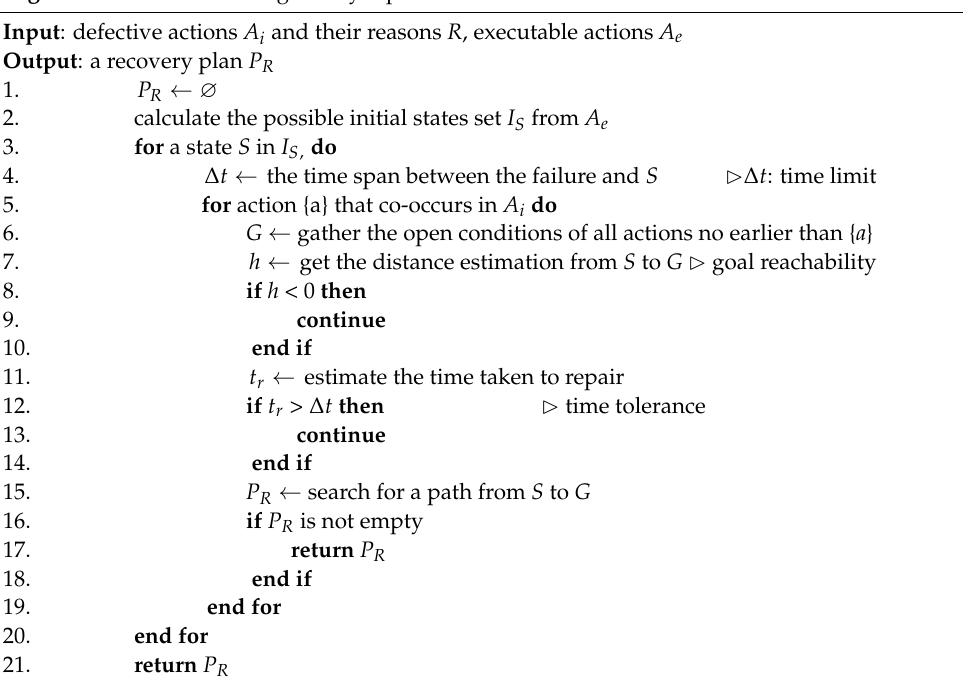
Algorithm 2 Multi-factor regulatory